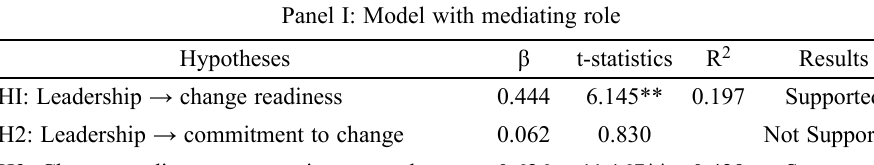
Table 4. Results of hypotheses testing (N =